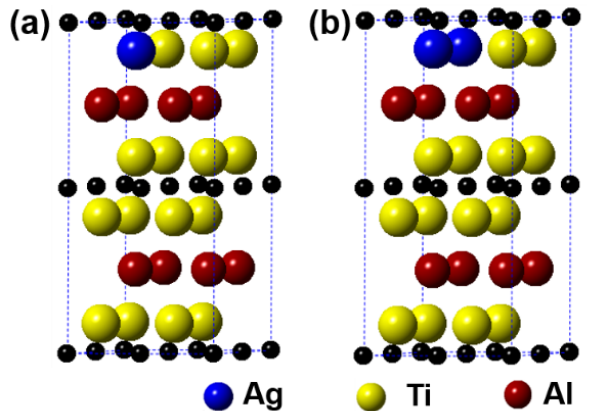
Figure 6. Models of the (Ti 1 − y ,Ag y ) 2 AlC supercells with different substitution ratios of Ag for Ti: ( a ) (Ti 0.9375 ,Ag 0.0625 ) 2 AlC; ( b ) (Ti 0.875 ,Ag 0.125 ) 2 AlC. Table 4. Effect of substitution ratio of Ag for Ti on lattice structure and stability of (Ti 1- y , Ag y ) 2 AlC supercells.